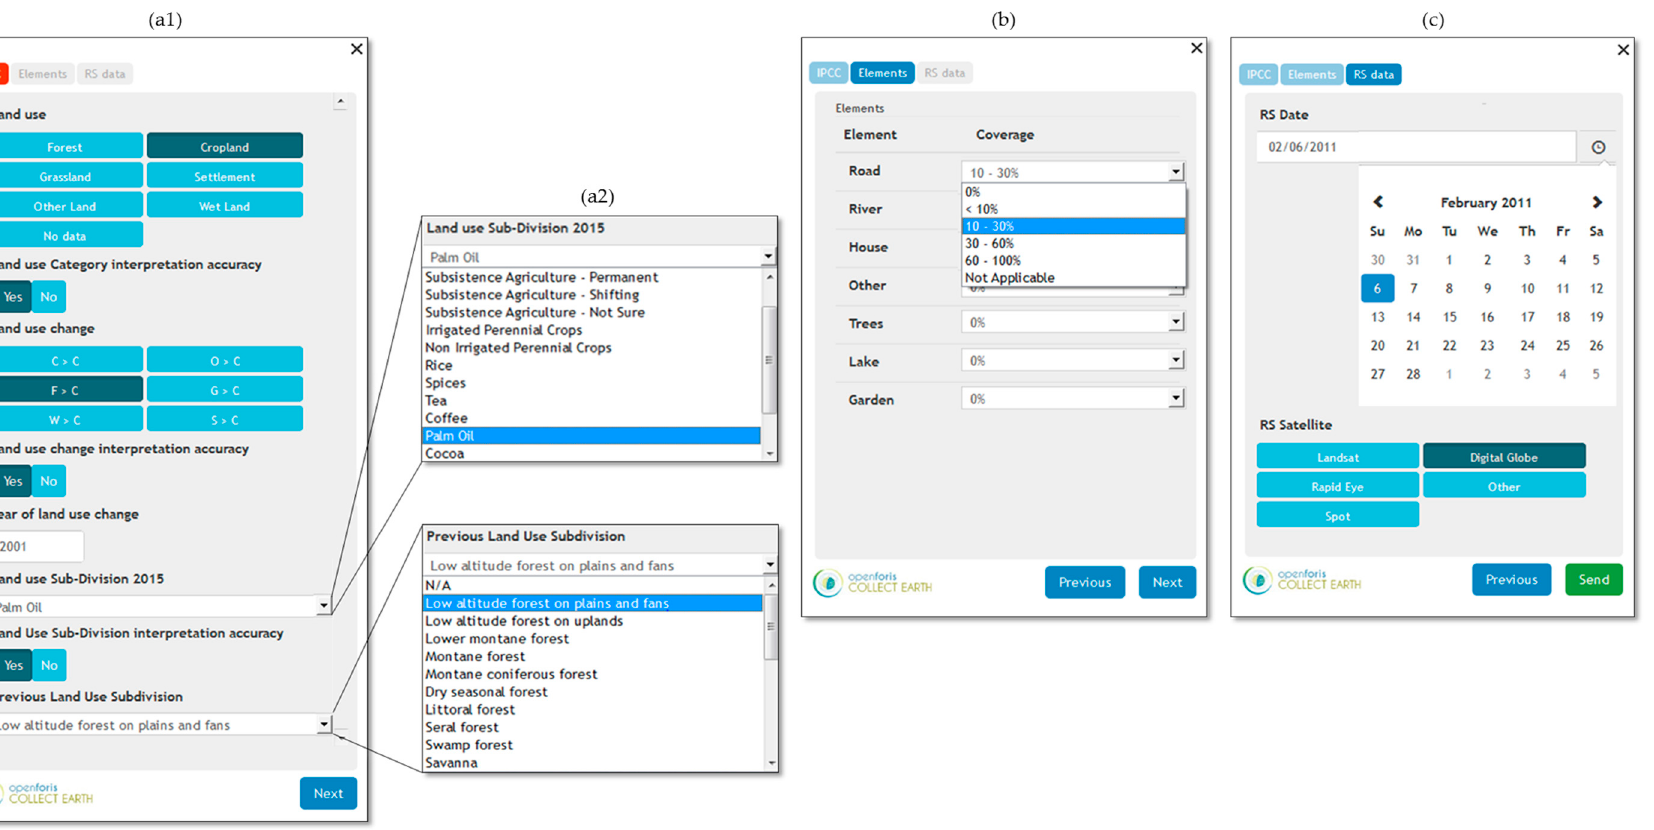
Figure 2. Illustration of a Collect Earth data collection form including the IPCC Land Use and Land Use Change ‘card’ ( a1 ); as well as the subdivisions per land use ( a2 ); the land cover elements to be measured ( b ) and the information on the remote sensing data used to assess each plot ( c ).